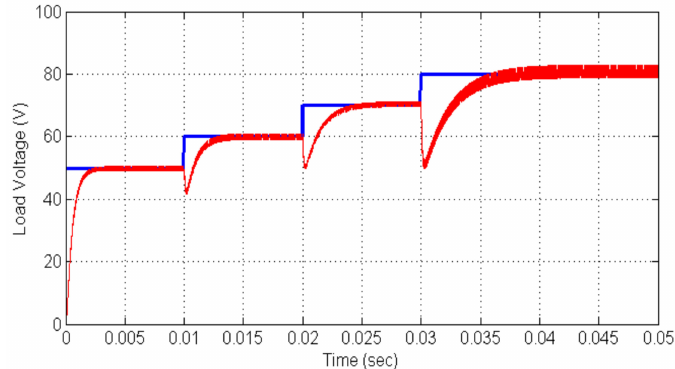
Figure 16. Response of load voltage to reference